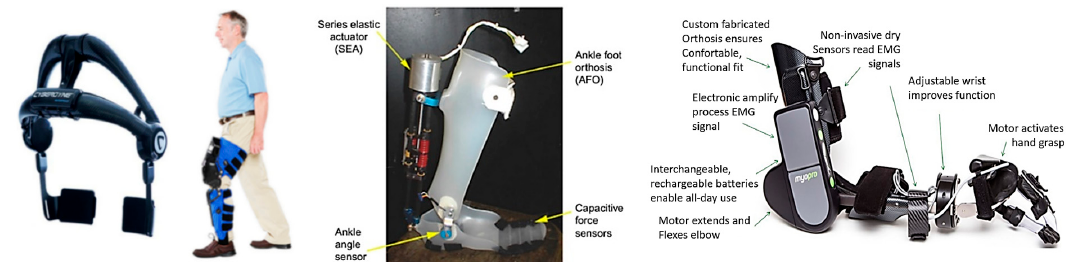
Figure 5. Hip, knee, ankle, and elbow-wrist-hand orthoses